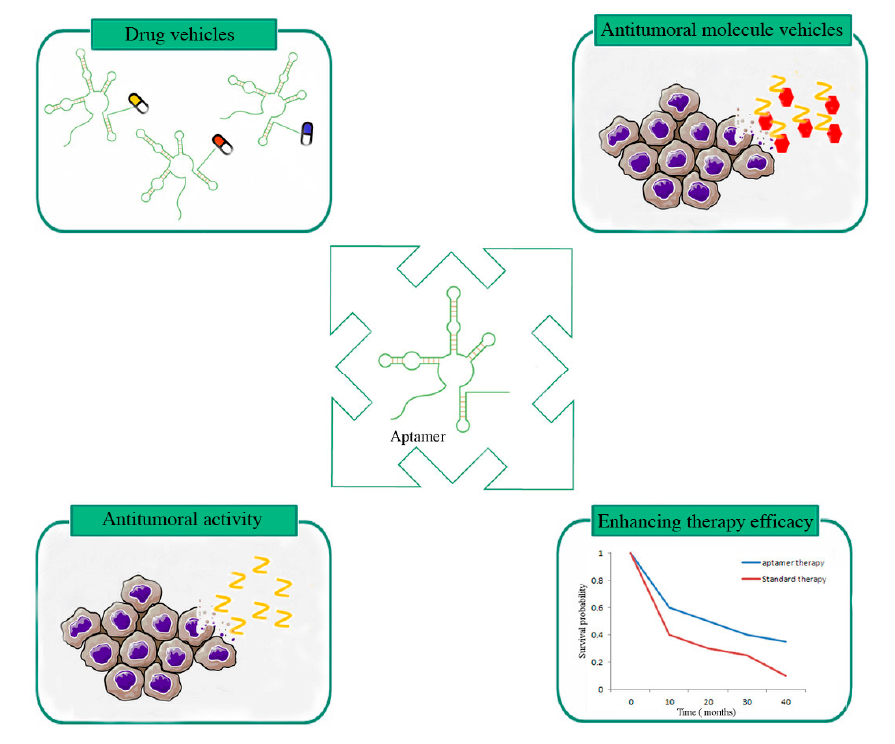
Figure 2. Schematic representation of aptamers in in vivo applications.